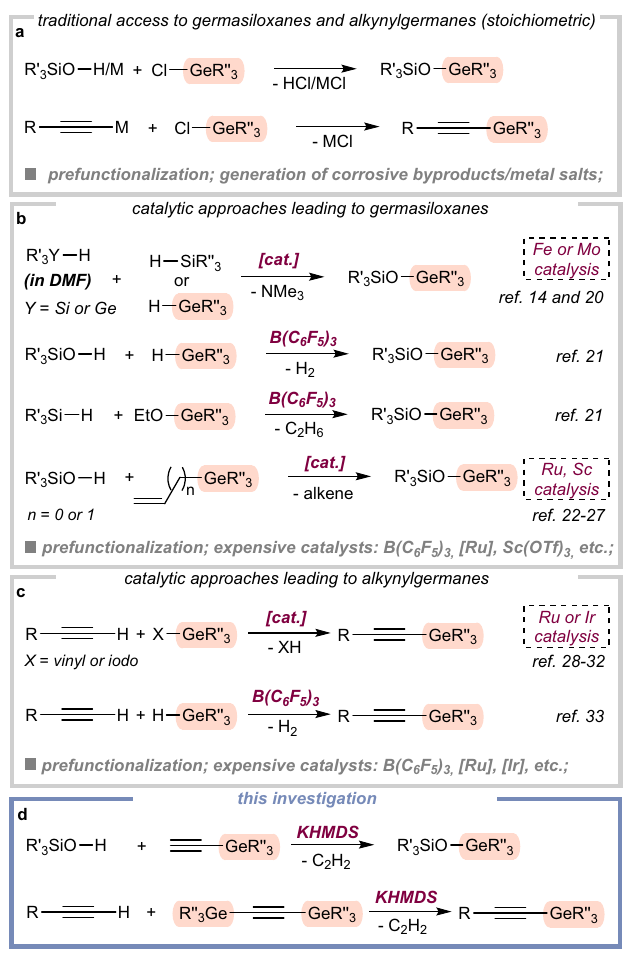
Figure 1. Context of the